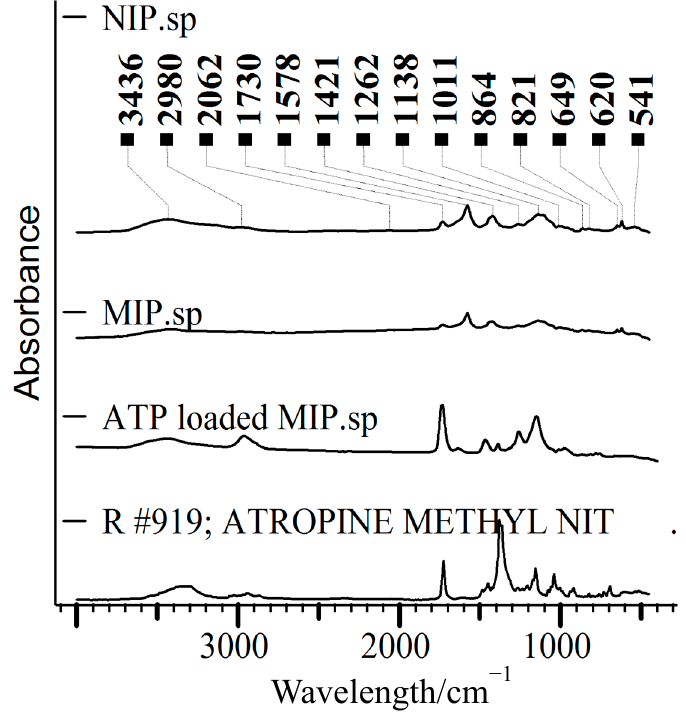
Figure 2. Infrared (KBr pellet) spectra of non-molecularly imprinted polymer (NIP), MIP, ATP-loaded MIP, and ATP.